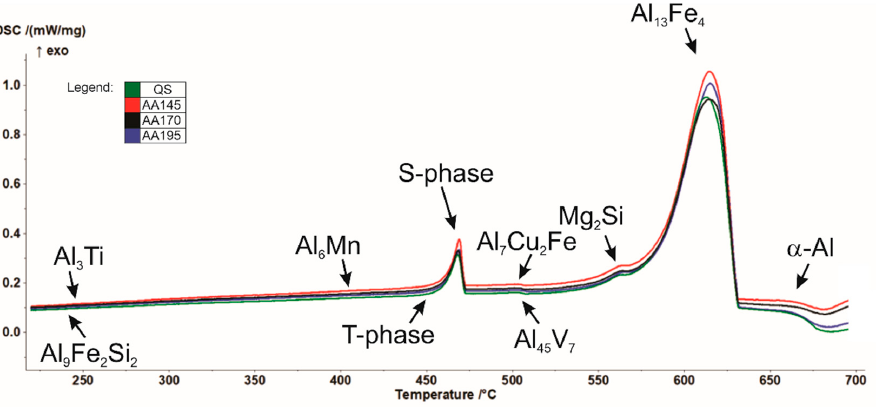
Figure 3. Cooling curves of the tested AA7075 specimens.